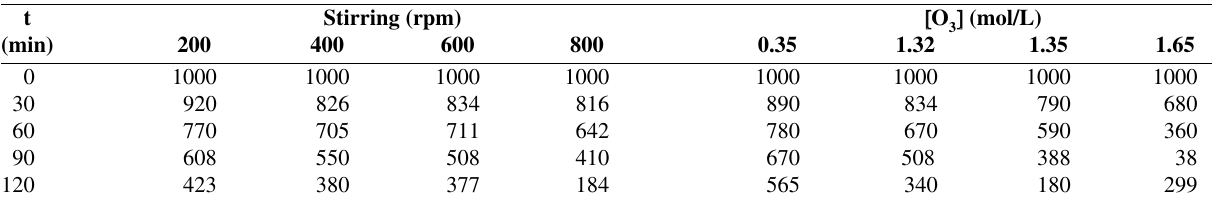
Table 1. Manganese concentration (mg/L, in italics) remaining in solution, with respect to stirring speed (rpm), ozone concentration (mol/L) and reaction time